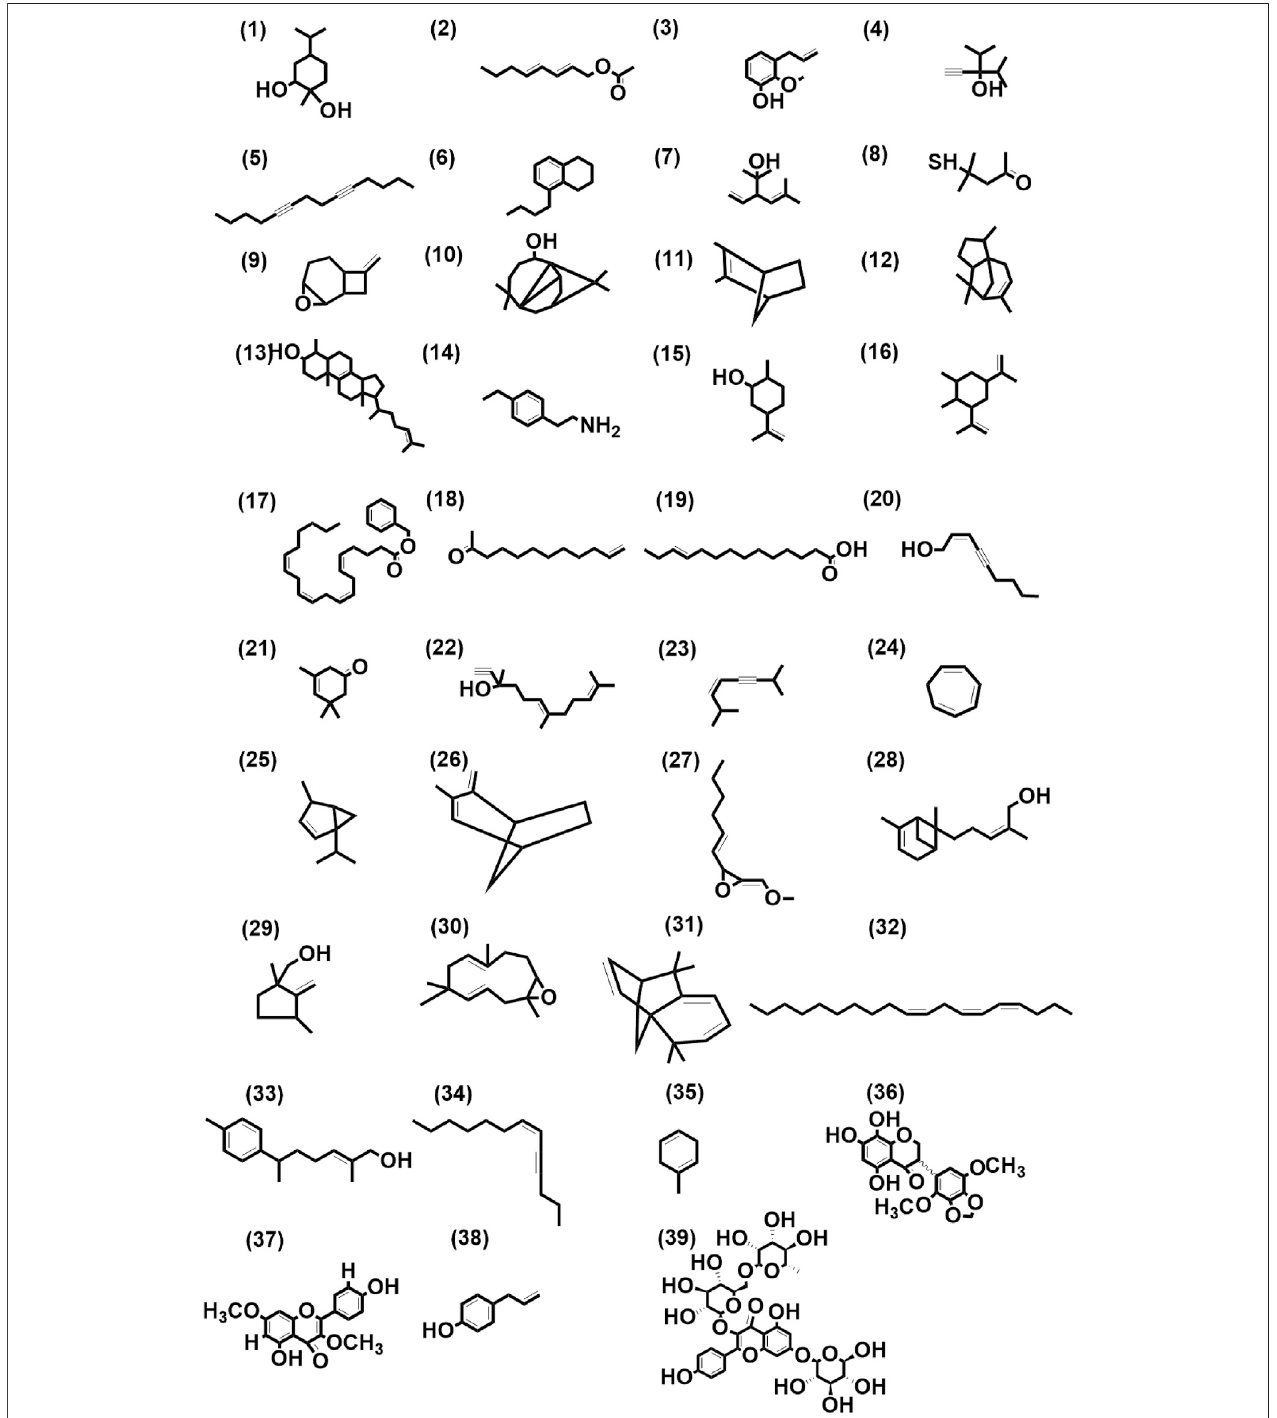
FIGURE 2 | Structures of fi rst-time reported (total 39) from the genus Curcuma , identi fi ed from cultivars of Curcuma longa L. and C. aromatica Salisb. detected in essential oil (panel numbers 1 – 23 and 24 – 35 corresponding to serial numbers 1 – 23 and 1 – 12 of Tables 2 , 3 respectively) and rhizome extracts (panel numbers 36 and 37 – 39 corresponding to serial numbers 1 and 1 – 3 of Tables 6 , 7 respectively) by GC-MS and LC-MS, respectively. Details of all these compounds are given in Supplementary Tables S3, S4 . (1) 1,2-Cyclohexanediol, 1-methyl-4-(1-methylethyl)-, (2) trans, trans-octa-2,4-dienyl acetate, (3) phenol, 2-methoxy-3-(2- propenyl)-, (4) 3-isopropyl-4-methyl-1-pentyn-3-ol, (5) 5,9-tetradecadiyne, (6) naphthalene, 5-butyl-1,2,3,4-tetrahydro-, (7) santolina alcohol, (8) 2-pentanone, 4- mercapto-4-methyl-, (9) 8-methylene-3-oxatricyclo[5.2.0.0(2,4)]nonane, (10) 7-tetracyclo[6.2.1.0(3.8)0(3.9)]undecanol, 4,4,11,11 tetramethyl-, (11)